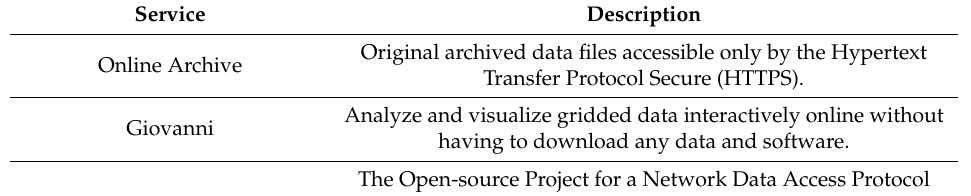
Table 4. Data services at GES DISC (note: data services may not be available for some datasets).